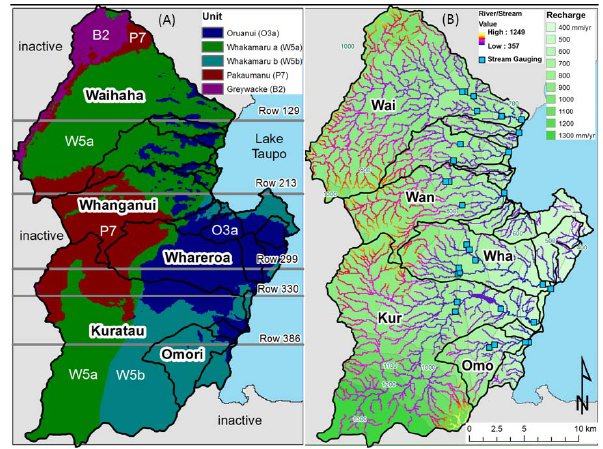
Fig. 1. Plan view of the western Lake Taupo catchment showing hy- drogeology model (A) and boundary conditions (B) . The catchment boundaries are shown by solid black lines and inactive cells by light grey. For the hydrostratigraphy in (A) , the dark blue is the Oruanui unit (O3a), the dark green colour the Whakamaru unit a (W5a), the light green the Whakamaru unit b (W5b), the dark red the Pakau- manu unit (P7) and the pink colour the greywacke basement unit (B2). The cross-sections along rows 129, 213, 299, 330 and 386 are shown in Fig. 2. The Waihaha (Wai), Whanganui (Wan), Whareroa (Wha), Kuratau (Kur) and Omori (Omo) catchments with tritium measurements are indicated with letters in (B) . For the MODFLOW model, Lake Taupo (blue area) is represented as a constant head boundary, rivers/streams implemented as Cauchy head-dependant drain cells, and groundwater recharge implemented in 10 zones as specified flux boundaries. The elevation of drain cells is shown in colour code from 357 to 1249m. For the MT3DMS model, the tri- tium input concentrations are assigned as recharge concentration. The stream gauging stations are shown by blue